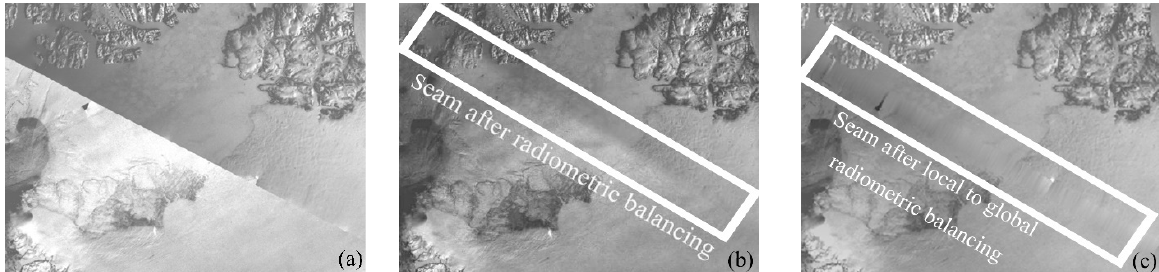
Figure 19. Compare with results by different method. ( a ) Original image. ( b ) Result by using radiometric balancing [1]. ( c ) Result by using local to global radiometric balancing.